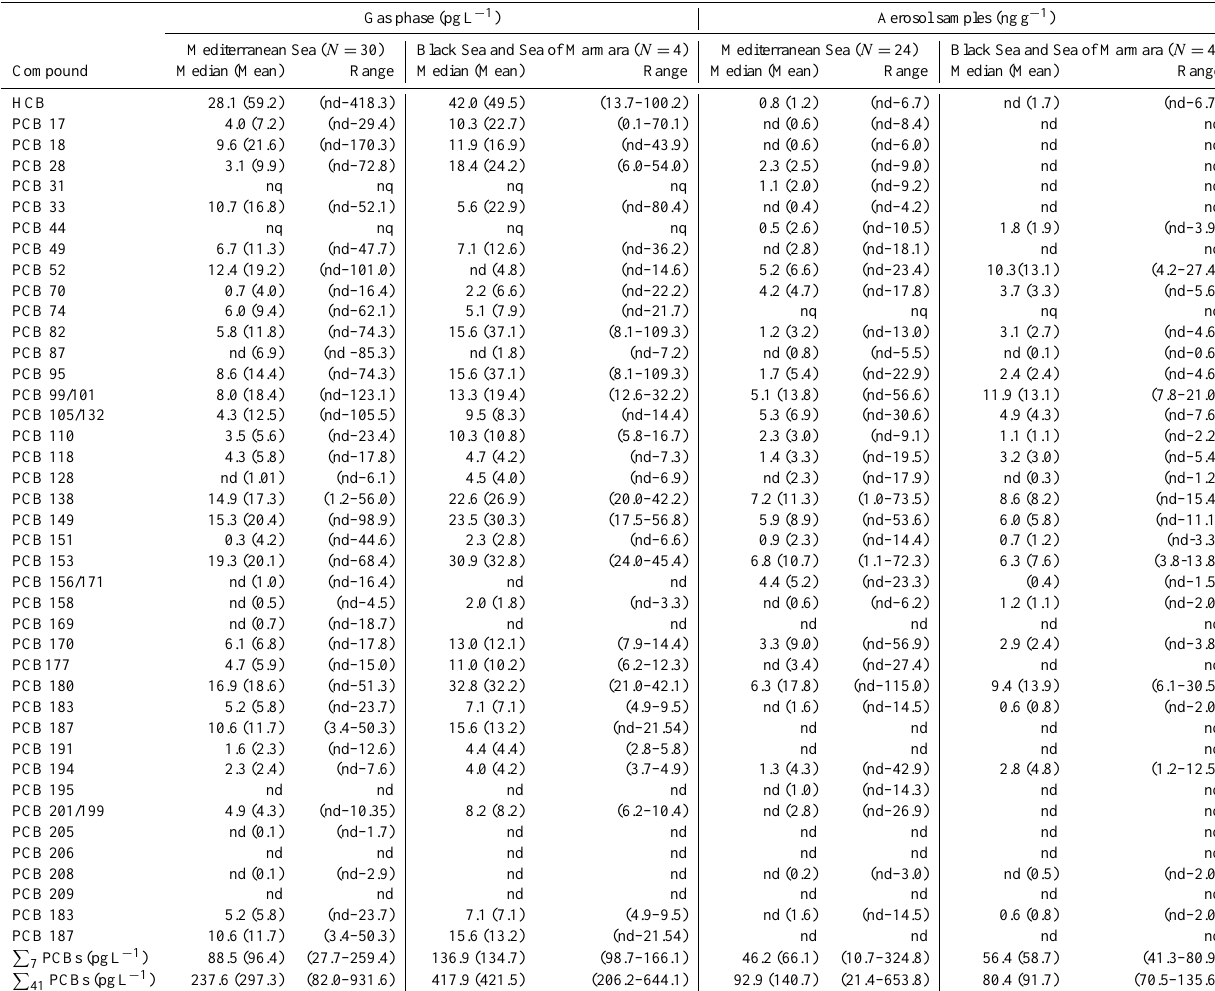
Table 1. Summary of the PCB and HCB concentrations in the Mediterranean